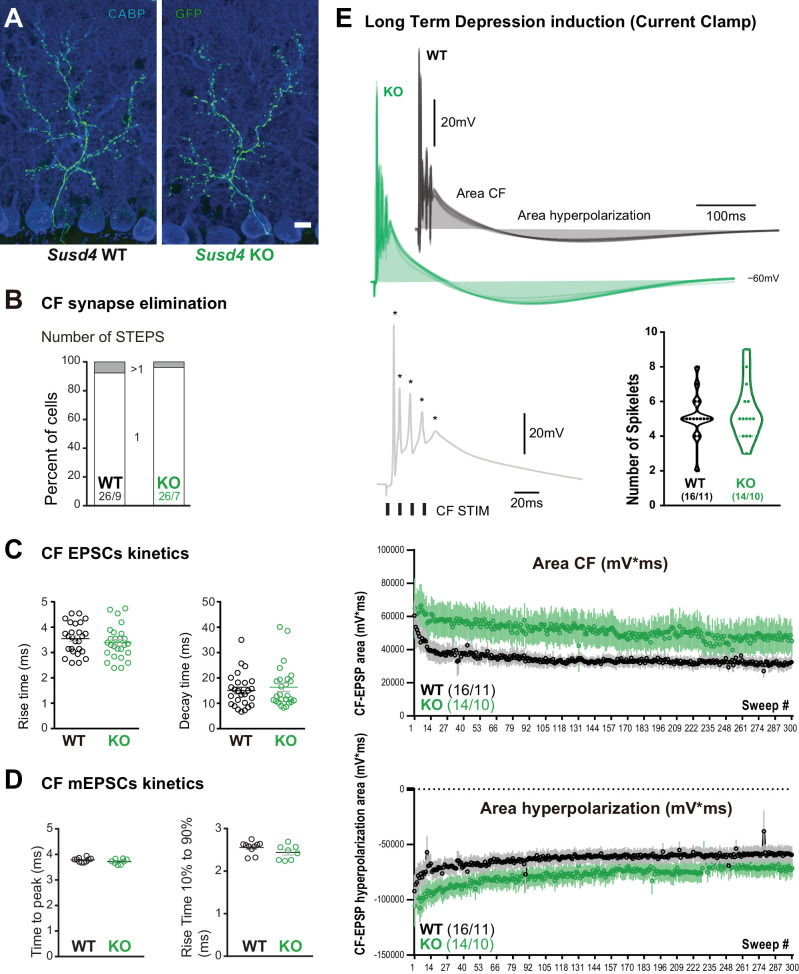
Characteristics of the climbing fiber (CF)/Purkinje cell (PC) synapse.(A) CFs were visualized in Susd4 wild-type (WT) and knockout (KO) mice crossed with Htr5b-eGFP reporter mice expressing the green fluorescent protein (GFP) specifically in inferior olivary neurons. Anti-GFP and anti-CABP (to visualize PCs) immunolabeling was performed on parasagittal sections of P30 mice and showed no qualitative differences in the absence of Susd4 expression. Scale bar 10 µm. (B) Patch-clamp recordings of PCs showed a similar percentage of mono- (one climbing fiber) and multi-innervation (>1 CFs) of PCs in P30 Susd4 KO and WT mice, as measured by the number of steps elicited by electrical stimulation of the CFs (WT n = 26 cells from nine mice and KO n = 26 cells from seven mice; chi-square test, p=0.5520). (C) No change in the rise and decay times of CF/PC excitatory postsynaptic currents (EPSCs) was induced by Susd4 deletion. Mean ± s.e.m. (WT n = 26 cells from nine mice and KO n = 26 cells from seven mice; rise time: unpaired Student’s t-test, p=0.3750; decay time: Mann-Whitney test, p=0.7133). (D) No change in the time to peak and in the rise time of CF/PC synapse-delayed EPSC quanta was induced by Susd4 loss-of-function. Mean ± s.e.m. (WT n = 10 cells from six mice and KO n = 8 cells from three mice; time to peak: unpaired Student’s t-test, p=0.1692; rise time 10-90%: Mann-Whitney test, p=0.0639). (E) CF/PC transmission was monitored during long-term depression (LTD) induction in current-clamp mode. Representative traces of the CF-EPSP are shown. The quantification of the number of spikelets (spikes induced by repeated CF stimulation [Mathy et al., 2009; Titley et al., 2019]) did not reveal any difference between WT and KO PCs (unpaired Student’s t-test, p=0.5791). Bottom: Measurements of the CF-EPSP area and hyperpolarization area during the LTD induction protocol. Mean ± s.e.m. (WT n = 16 cells from 11 mice and KO n = 14 cells from 10 mice).